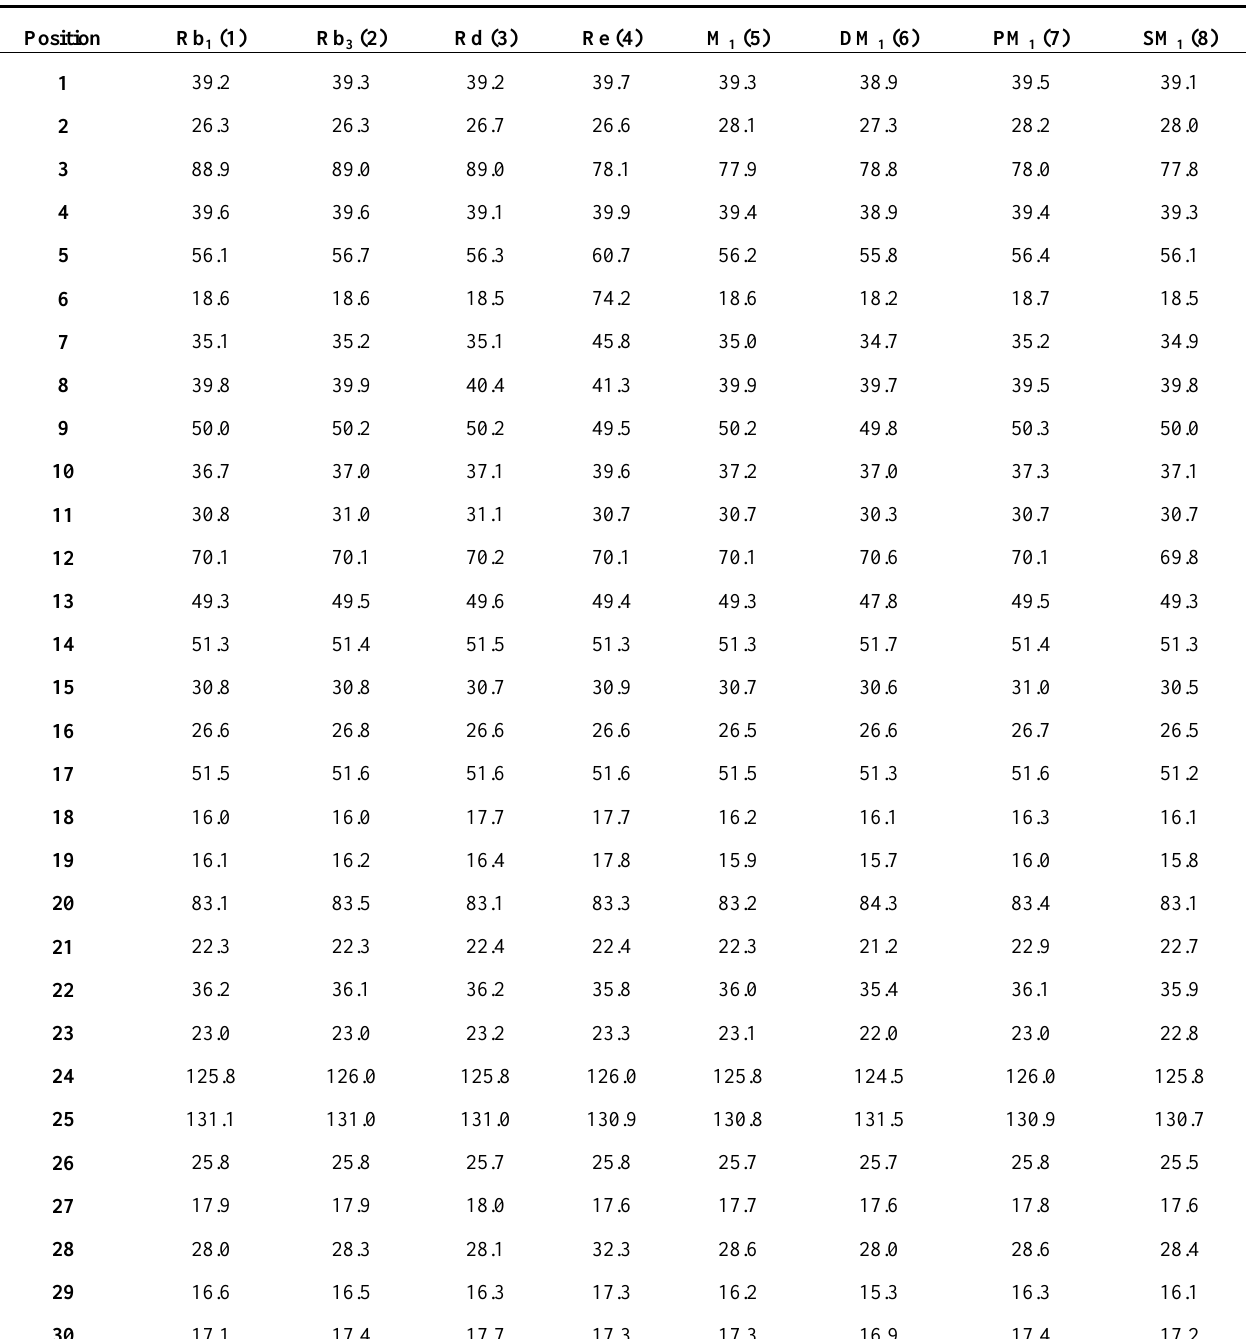
Table 1 . The 13 C NMR data of compounds 1 - 8 a